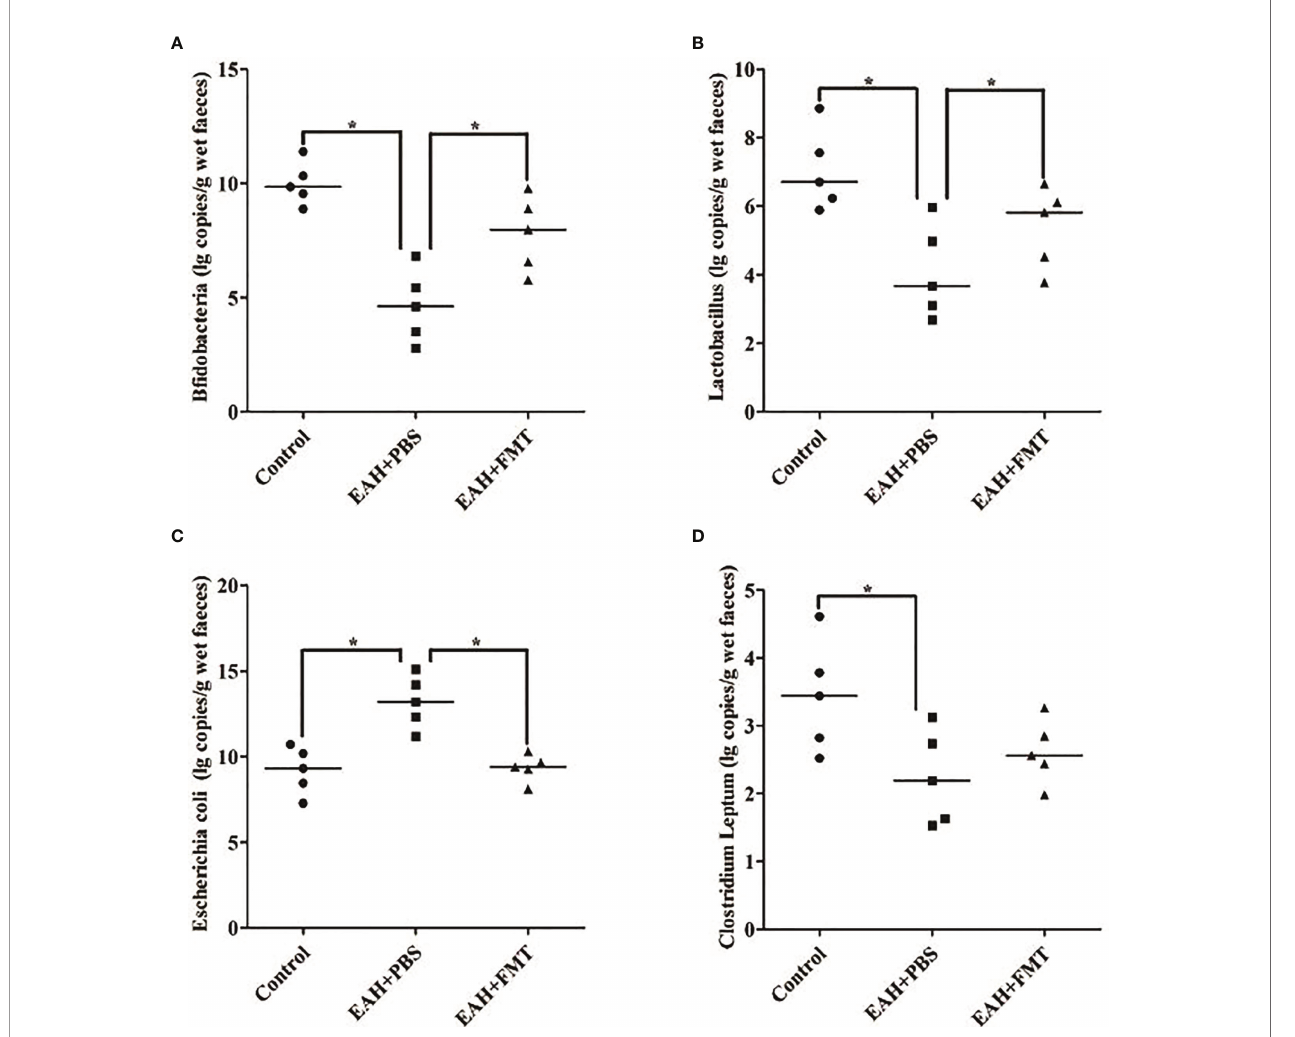
FIGURE 6 | FMT restored antibiotic-induced IM dysbiosis. Fecal samples on the 28th day of untreated and FMT-treated EAH mice are analyzed by the real-time PCR method. (A) Amounts of fecal Bi fi dobacteria ; (B) amounts of fecal Lactobacillus ; (C) amounts of fecal Escherichia coli ; (D) amounts of fecal Clostridium leptum . The horizontal lines indicate the mean values of the different groups. *p <